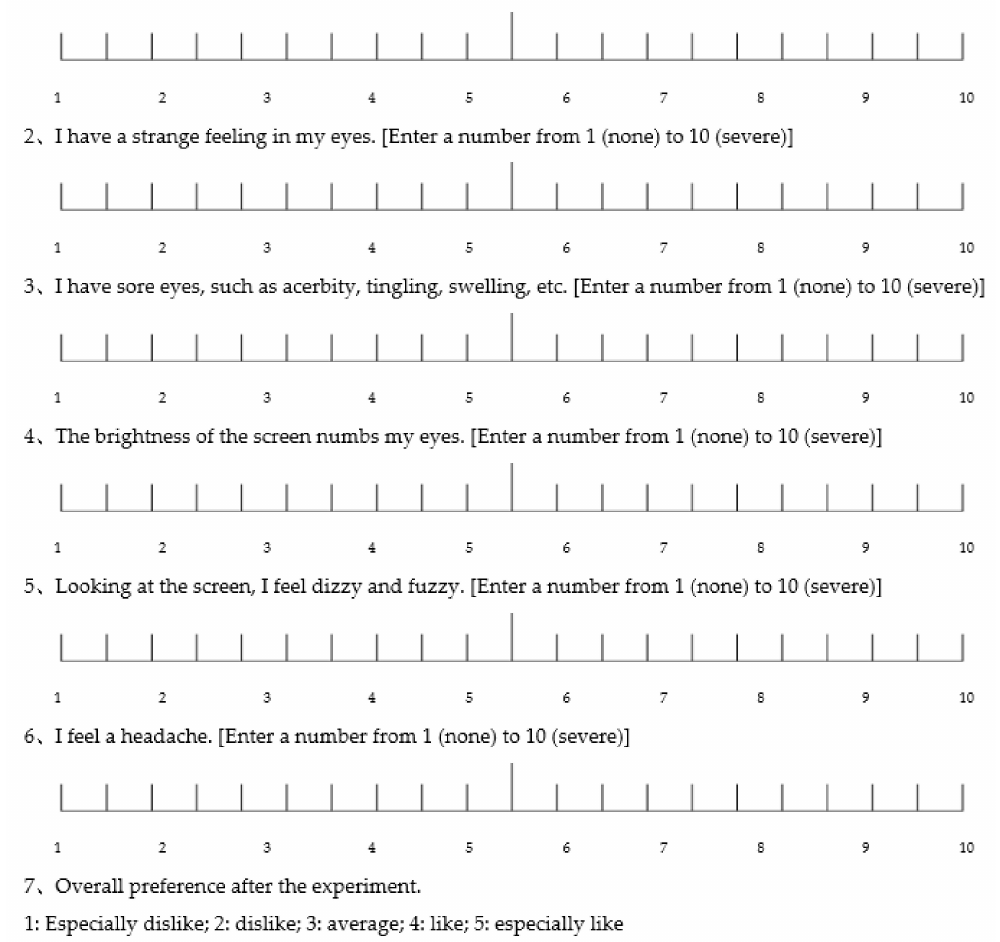
Figure A1. Likert Scale of Visual Fatigue